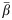
Comparison between RNA crosstalk in the CLASH interactome and its randomized counterparts.(a) Frequency of shortest miRNA-mediated paths between RNA species. The length corresponds to the minimum number of miRNA species that can mediate a crosstalk interaction between two RNA species. (b, c) Distributions of node degrees for RNAs (top) and miRNAs (bottom). (d, e) Mean and maximum susceptibilities as a function of β¯. (f, g) Pearson coefficient ρ¯ quantifying crosstalk locality and coefficient of variation of the levels of free RNAs as functions of β¯. In panels d through g, TH is fixed at CVtr = 0.4 and averages performed over 1000 independent realizations of TH under high BH. In each case, the standard error of the mean is equal to or smaller than the size of the markers.